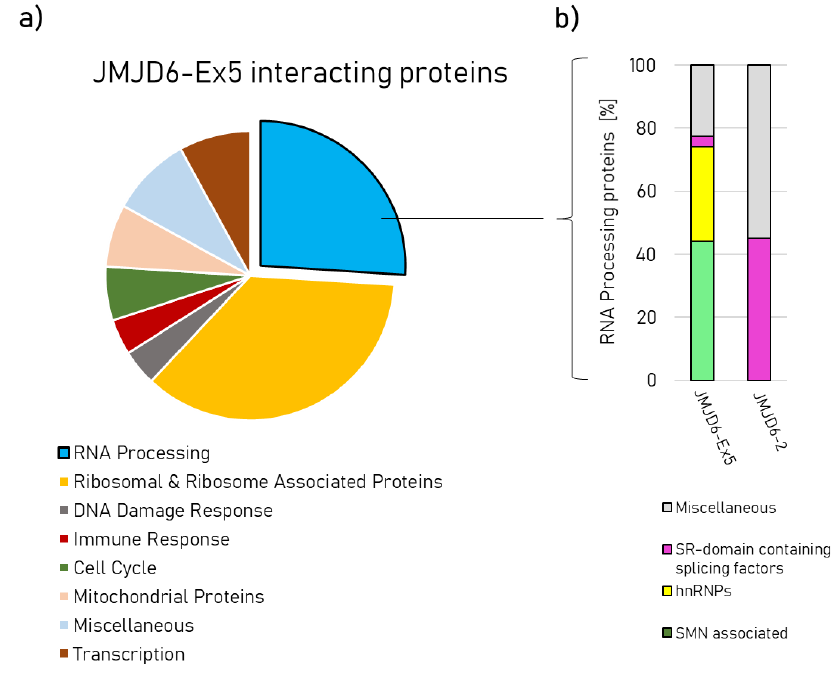
Figure 3. ( a ) Graphic representation of manually assigned functions for 101 proteins co-immunoprecipitated with HA-tagged JMJD6-Ex5 protein. ( b ) Specific assignments for the group of RNA-processing proteins co-immunoprecipitated by JMJD6-Ex5 (left-hand column) and JMJD6-2 (right-hand column, information from (Heim et al. (2014) [12]).